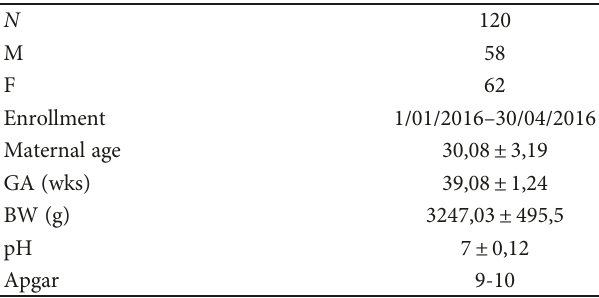
Table 1: Demographic and clinical characteristics of the study population.